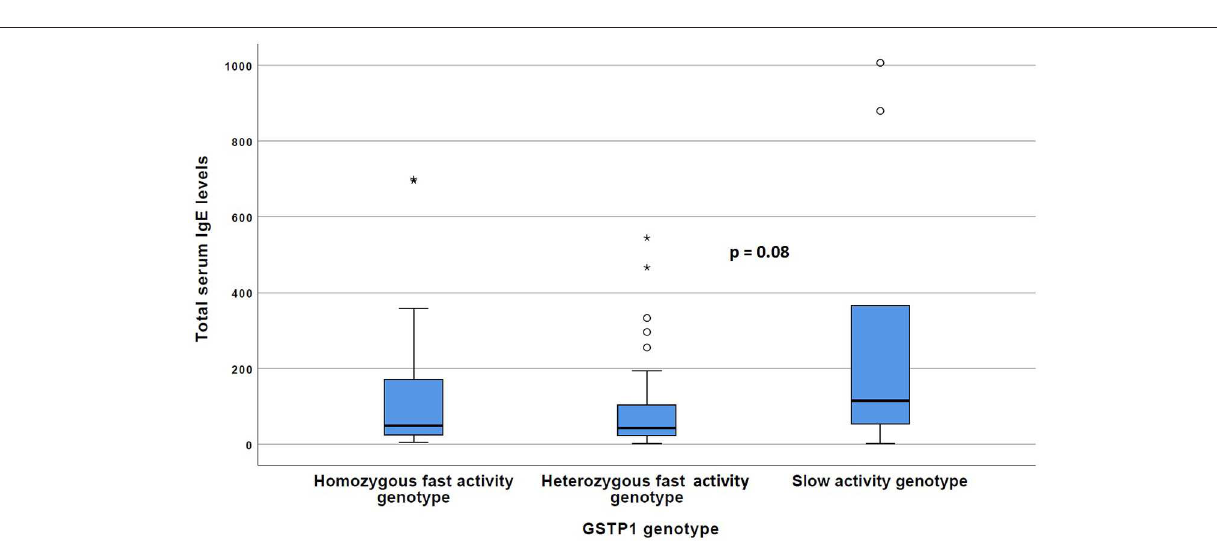
FIGURE 2 | The total IgE levels of the patients with GSTP1 slow activity genotype compared with those with homozygous fast activity and heterozygous fast activity genotypes. Boxplots with median (line) and respective 25 and 75 percentiles are given, outliers indicated with circles and asterisks. P -value has been received with the Kruskal–Wallis